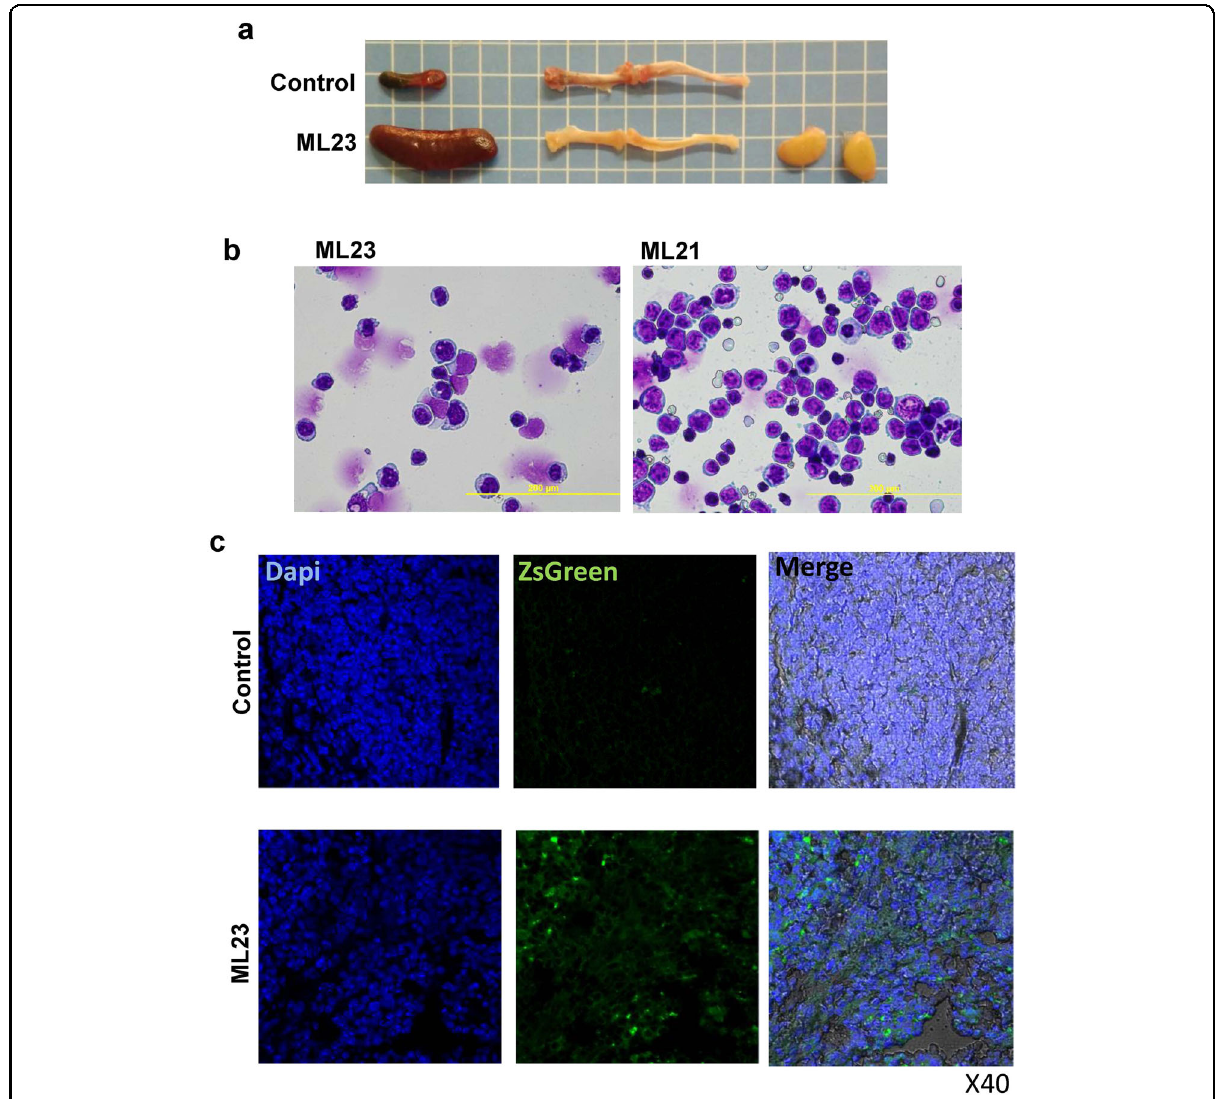
Fig. 4 Leukemia pathophysiology and microscopic examination. a Enlarged spleen and lymph-nodes of an ML23 mouse, alongside bones lacking the normal reddish-hematopoiesis marrow are shown, normal spleen and bone marrow of a control-healthy mouse are presented for comparison (representative of n = 7 mice). b Giemsa-stained ML23 or ML21 cells at ×20 – 40 magni fi cation. c Spleens sections from WT, or ML23 mice, with nuclear-staining with Dapi. Green fl uorescence is detected from ZsGreen-tagged spleen cells in the ML23 mice